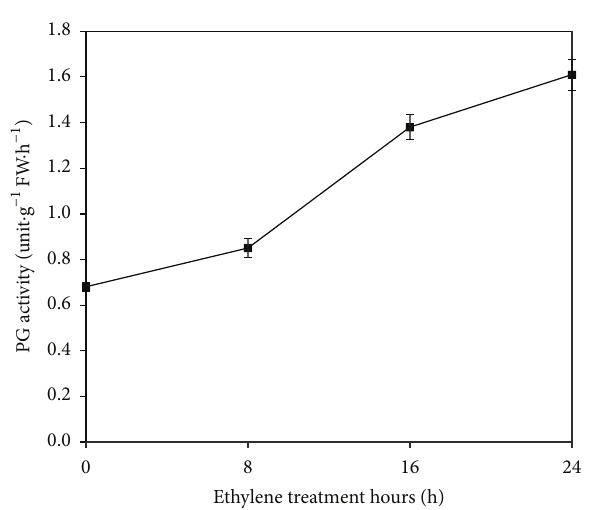
Figure 2: Effect of ethylene on polygalacturonase (PG) activity in tomato pedicel explants. Vertical bars indicate ± S.E. ( 𝑛 = 3